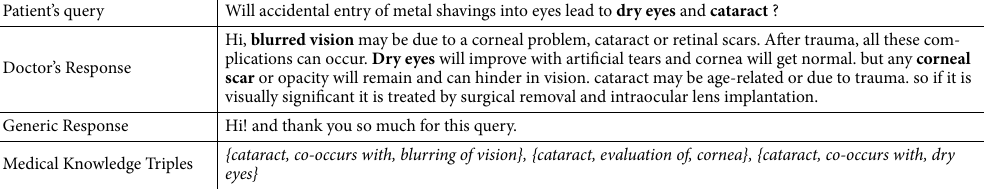
Table 1. An example from the MedDialog(EN) dataset illustrating the lack of global medical knowledge in existing dialogue models. The generic response was observed during the inference stage by previous